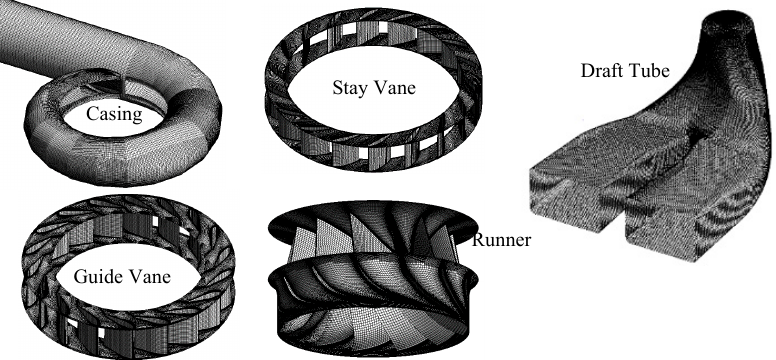
Figure 12. Numerical grids of the 100 MW class Francis turbine.